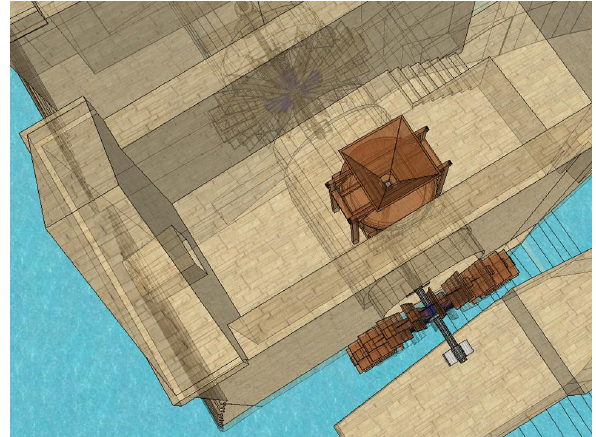
Figure 9: Simplified representation of the mill motion with in- serted machinery